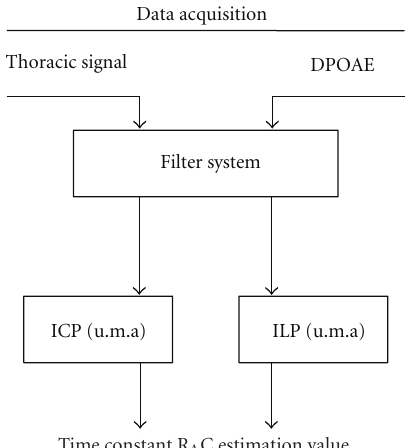
Figure 1: The following diagram shows the methodology of how the time constant is estimated. The infrasonic waves of the ICP and ILP were filtered from the thoracic and DPOAE signals; each infrasonic wave was between (0.166 Hz, 0.5 Hz), noticed that the reference [26] gives more details about the filter